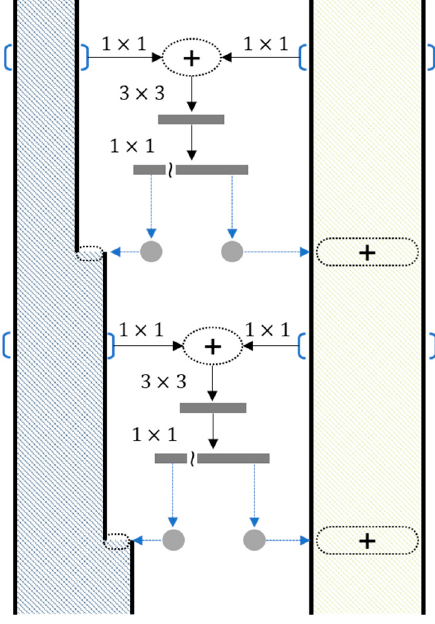
Figure 9. Dual Path Net (DPN) structure diagram [42].